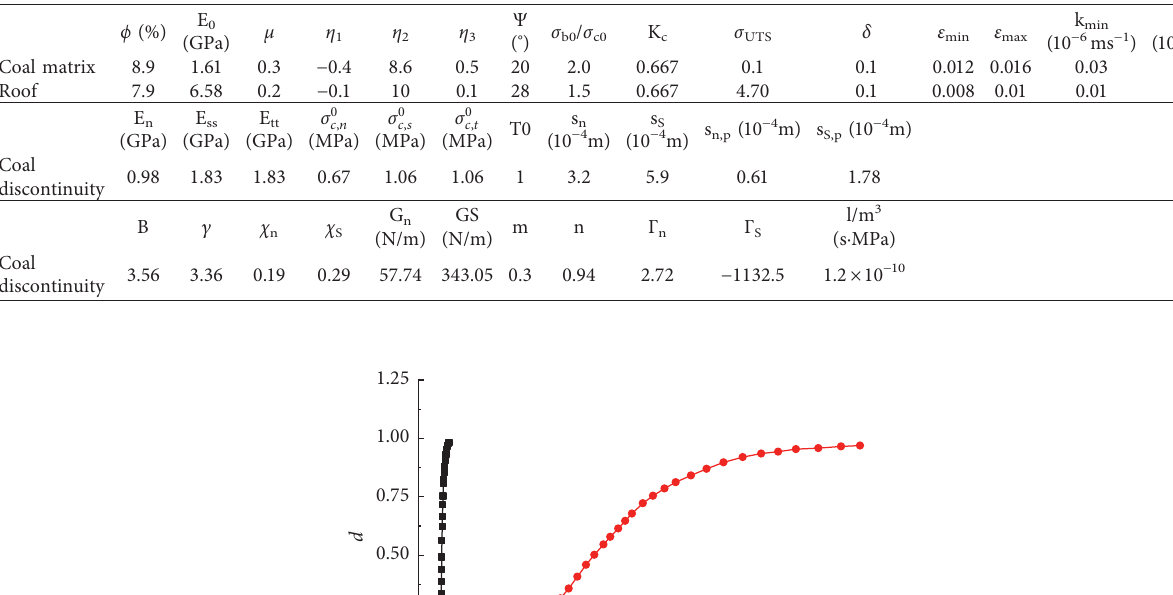
Table 1: Mechanical parameters.